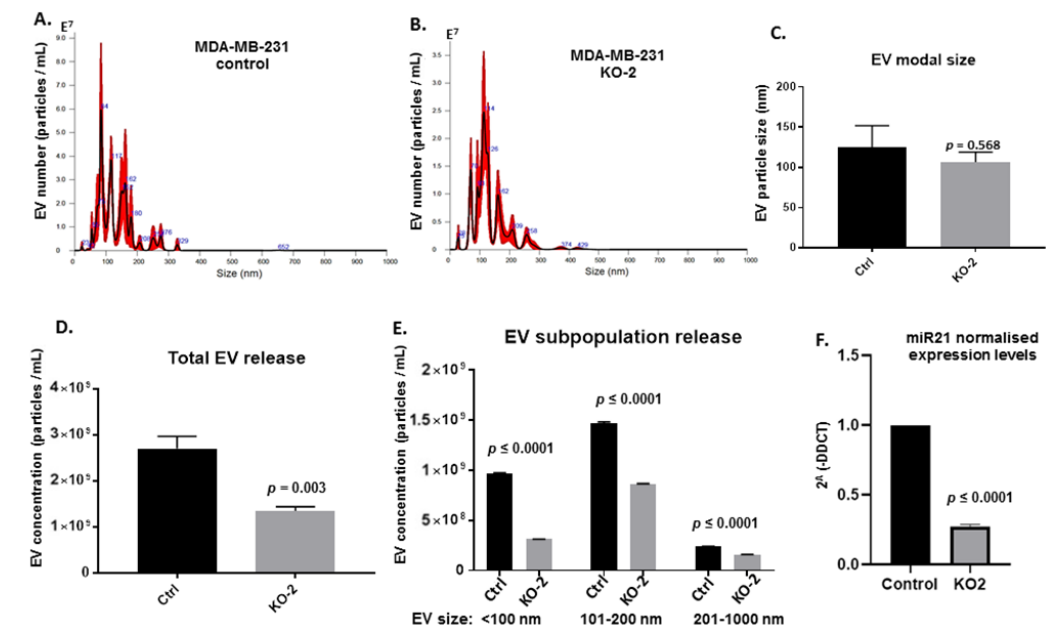
Figure 3. Extracellular vesicle (EV) analysis of miR-21 knockout MDA-MB-231 cells. ( A ) Representative nanoparticle tracking analysis (NTA) profile of extracellular vesicles (EVs) derived from control MDA-MB-231 cells. ( B ) Representative NTA profile of EVs derived from miR-21 knockout (KO-2) MDA-MB-231 cells. ( C ) EV modal size for EV profiles from control versus miR-21 (KO-2) MDA-MB-231 cells. ( D ) Total EV release is significantly reduced in the miR-21 KO cells. ( E ) Cellular release of all three EV subpopulations is significantly reduced in the miR-21 KO, compared with control MDA-MB-231 cells. ( F ) EV cargo assessed for miR-21 shows a significant reduction in miR-21 content in EVs derived from the miR-21 KO (70%), compared with EV miR-21 cargo from control MDA-MB-231 cells. Exact p -values are indicated ( n = 3).